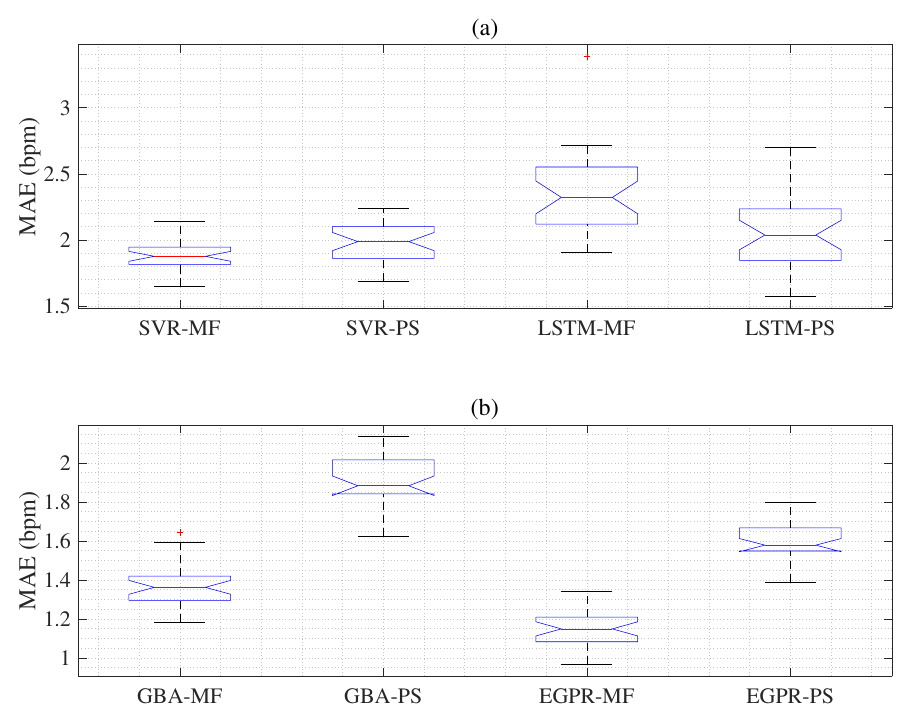
Figure 5. Top panel ( a ) represents the MAE and SD compared to the reference RR method acquired from the ECG-based SVR-MF, ECG-based SVR-PS, ECG-based LSTM-MF, and ECG-based LSTM-PS models. Bottom panel ( b ) shows the MAE and SD compared to the reference RR method obtained from the ECG-based GBA-MF, ECG-based GBA-PS, ECG-based EGPR-MF, and ECG-based EGPR-PS.